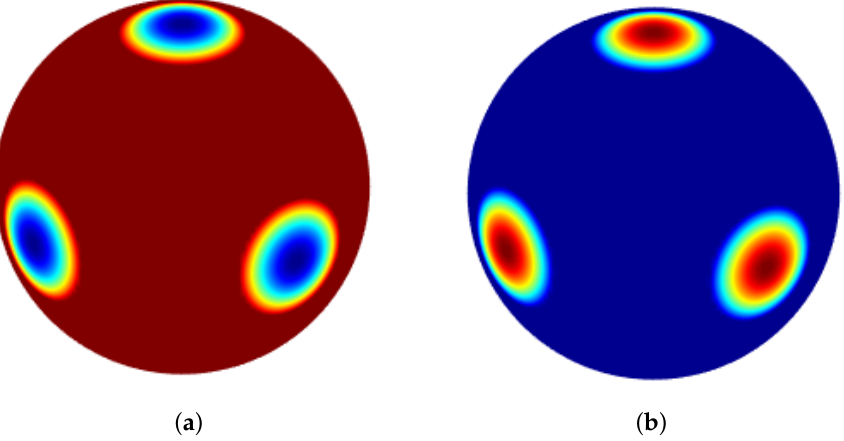
Figure 8. The plot of approximate solution of u ( a ) and the plot of approximate solution of v ( b ) with TPS for Example 4 by taking dx = 1 , and τ = 0.5 dx 2 . 8